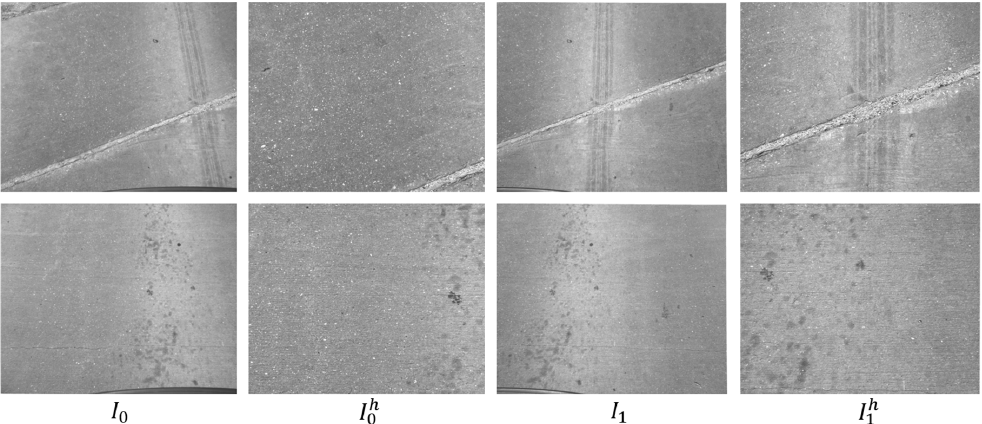
Figure 11. Images collected through our multi-view camera system. Each row represents one frame